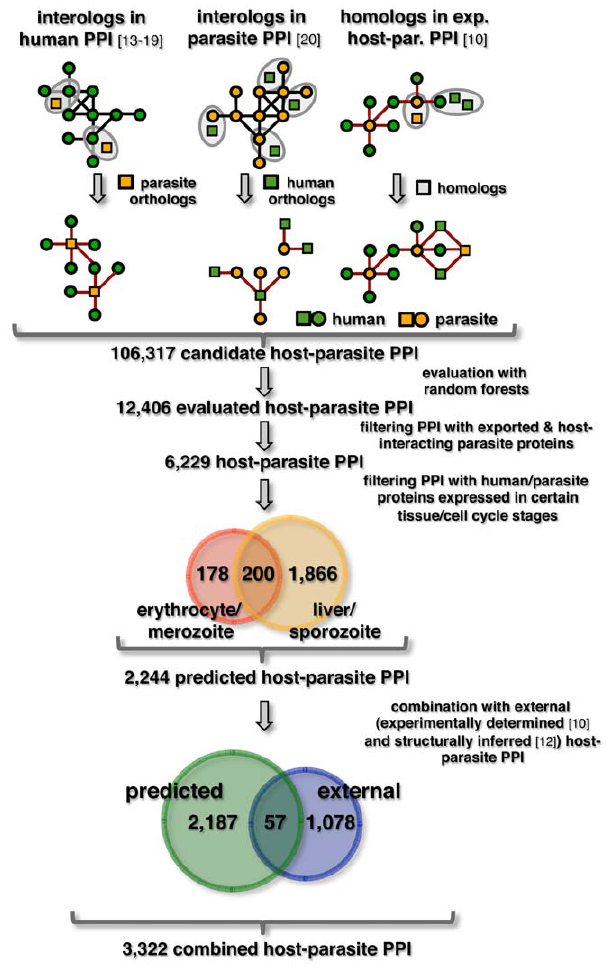
Figure 1. Procedure to determine interactions between human host and parasite proteins. A candidate interaction was identified in the web of human interactions if an interacting human protein had an ortholog in P. falciparum . Analogously, a potential interaction occurred if a protein in the parasite interaction network had a human ortholog. In a set of experimentally determined host-parasite interactions a host- parasite interaction was found, if the interacting proteins had homologs in the corresponding organism. The combination of all sources provided a total of 106,317 candidate interactions. The quality of the predicted interactions was assessed using the random forest algorithm, a machine learning method that classifies interactions as a function of the corresponding protein’s sequences. Subsequently, 12,406 interac- tions thus obtained were filtered if they involved parasite proteins that were exported or carried molecular characteristics, enabling them to interact with the human host. While this step provided 6,229 interactions only host-parasite interactions were accounted for that occurred between proteins expressed in the parasitic merozoite stage and human red blood cell as well as in the sporozoite stage and liver cells. Accordingly, partially overlapping sets of 378 and 2,044 interactions were obtained, pooling a total of 2,244 predicted host- parasite protein interactions. In the last step predicted interactions were combined with external data such as structurally inferred and experimentally obtained interactions, providing a set of 3,322 combined host-parasite